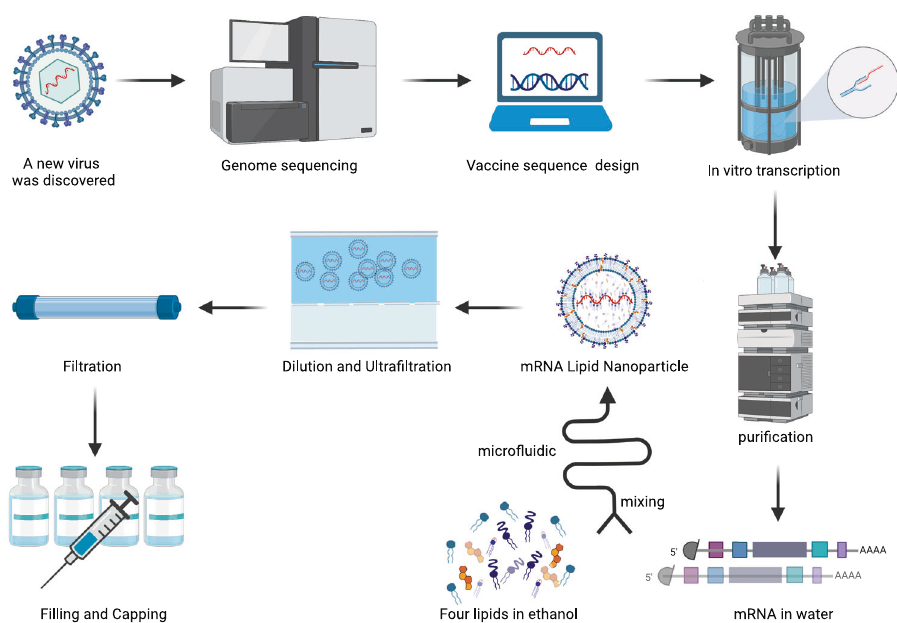
Fig. 8 Production process of mRNA vaccines. The design of an mRNA vaccine is conditioned to the de fi nition of the antigen sequence of the target pathogen. By determining the target antigen and optimizing its coding sequence, the mRNA can be transcribed in vitro by RNA polymerase. The synthesized mRNA is puri fi ed by different processes and then mixed with a lipid phase using micro fl uidics and encapsulated into an mRNA-lipid nanoparticle (mRNA-LNP) complex. Subsequently, self-assembly of LNPs is completed by dilution and concentration by ultra fi ltration. Finally, after sterile fi ltration, fi lling, and capping, the mRNA vaccine is